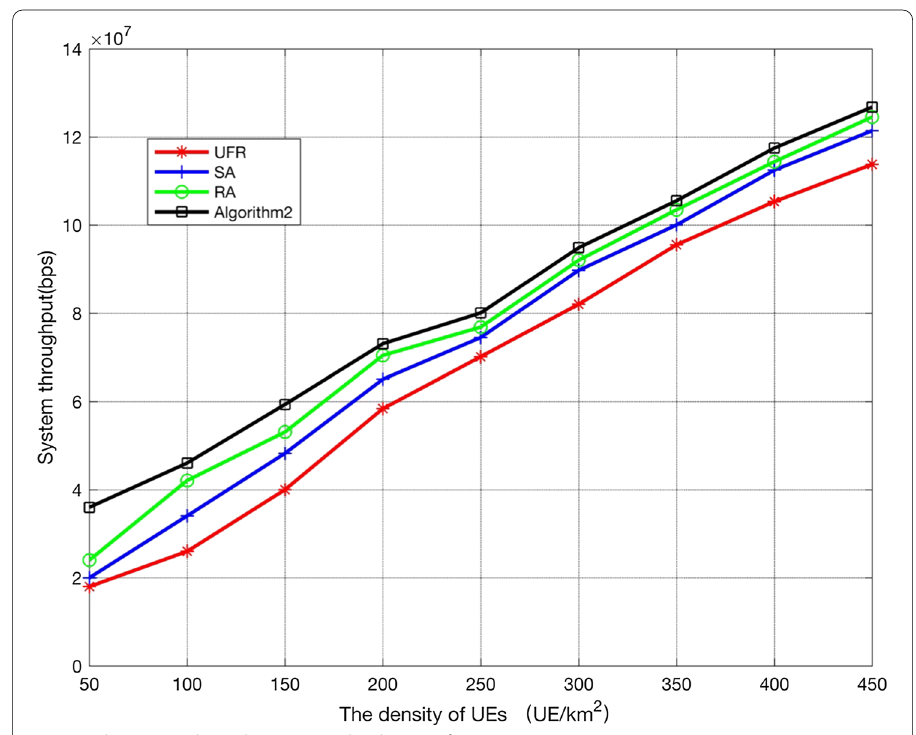
Fig. 11 The system throughput versus the density of UEs